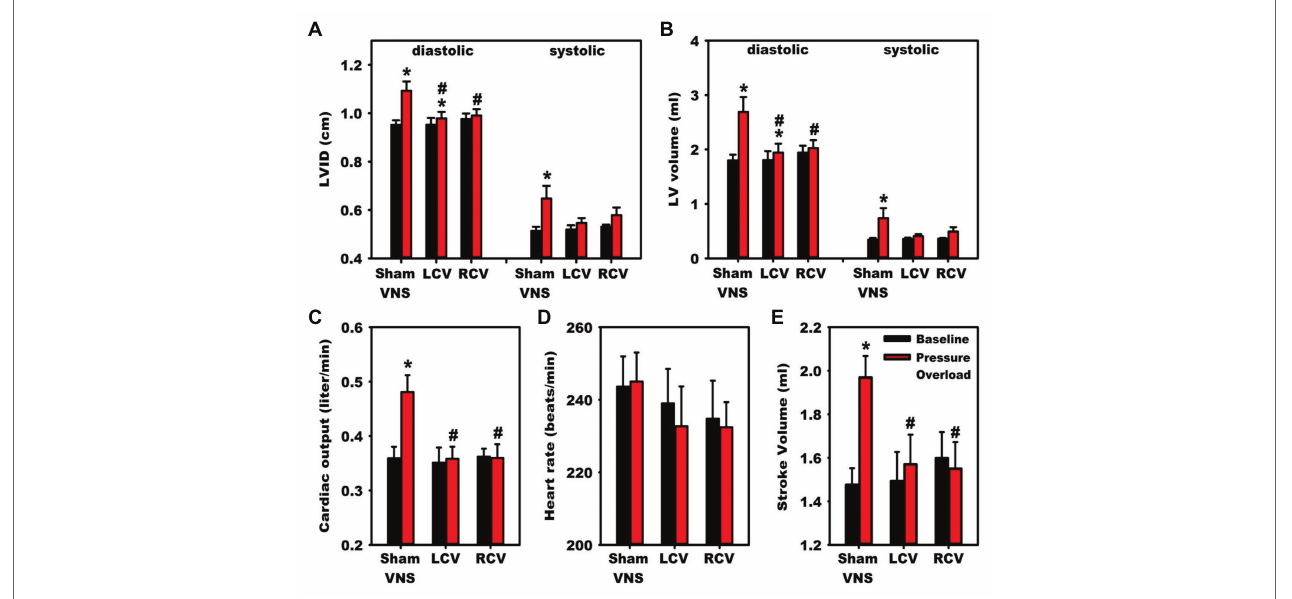
FIGURE 8 | Vagal nerve stimulation mitigates heart failure and cardiac hypertrophy in a guinea pig model of chronic pressure-overload induced by aortic constriction. Compared to animals receiving sham vagal nerve stimulation, those receiving right or left sided VNS had improvements in indices of heart failure. Significant improvements were noted in diastolic indices of (A) left ventricular (LV) internal diameter and (B) LV volume. (C) Cardiac output and (E) stroke volume normalized to baseline with left and right vagal nerve stimulation, with no changes in (D) Heart Rate. LCV, left cervical vagus stimulation. RCV, right cervical vagus stimulation. VNS, vagus nerve stimulation. LV, left ventricular. LVID, Left ventricular internal diameter. Adapted from Beaumont et al. (2016). * p < 0.05 from baseline; # p < 0.05 to sham